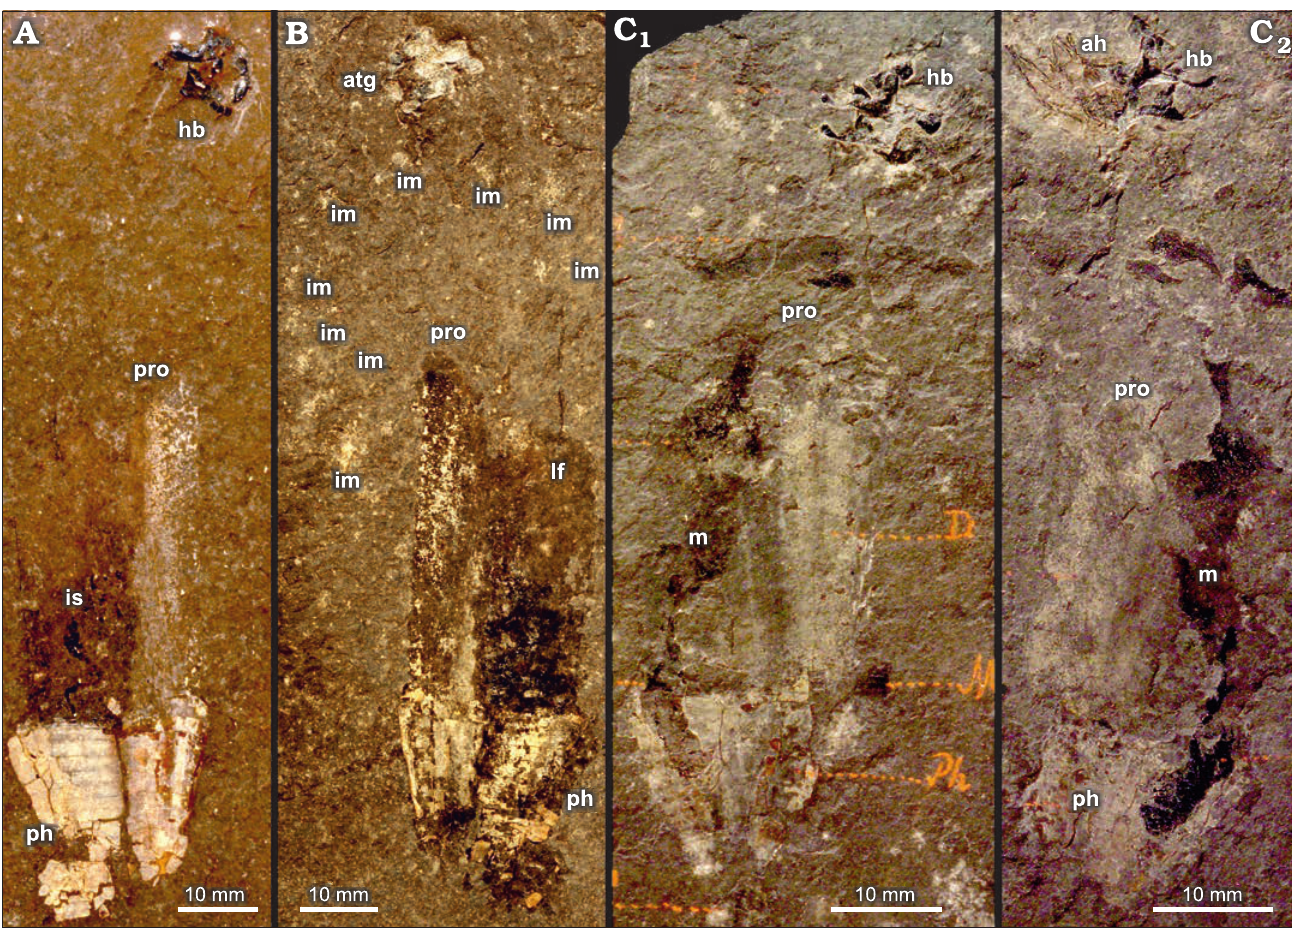
Fig. 2. Coleoid cephalopod Phragmoteuthis bisinuata (Bronn, 1859), overview of four specimens three of which (A, C, D) show the previously thought “beaks of P. bisinuata ”, and one (B) exhibits a whitish triangular structure with straight shoulders and a rachis-like process preliminary considered as a gladius of unknown Glochinomorpha -like teuthid; all lower Carnian, Upper Triassic, Cave del Predil, NE Italy. A . GBA 2006/011/0021. B . GBA 2006/011/0028. C . GBA 2006/011/0001, part (C 1 ) and counterpart (C 2 ). Abbreviations: ah, arm hook; atg, assumed triangular posterior part of a gladius of a small squid prey of P. bisinuata ; hb, hypothesized “beaks of P. bisinuata ”; im, discrete imprints arranged in a shape of an oval in front of proostracum; is, ink sac; lf, lateral field of proostracum; m, mantle debris; ph, phragmocone; pro,